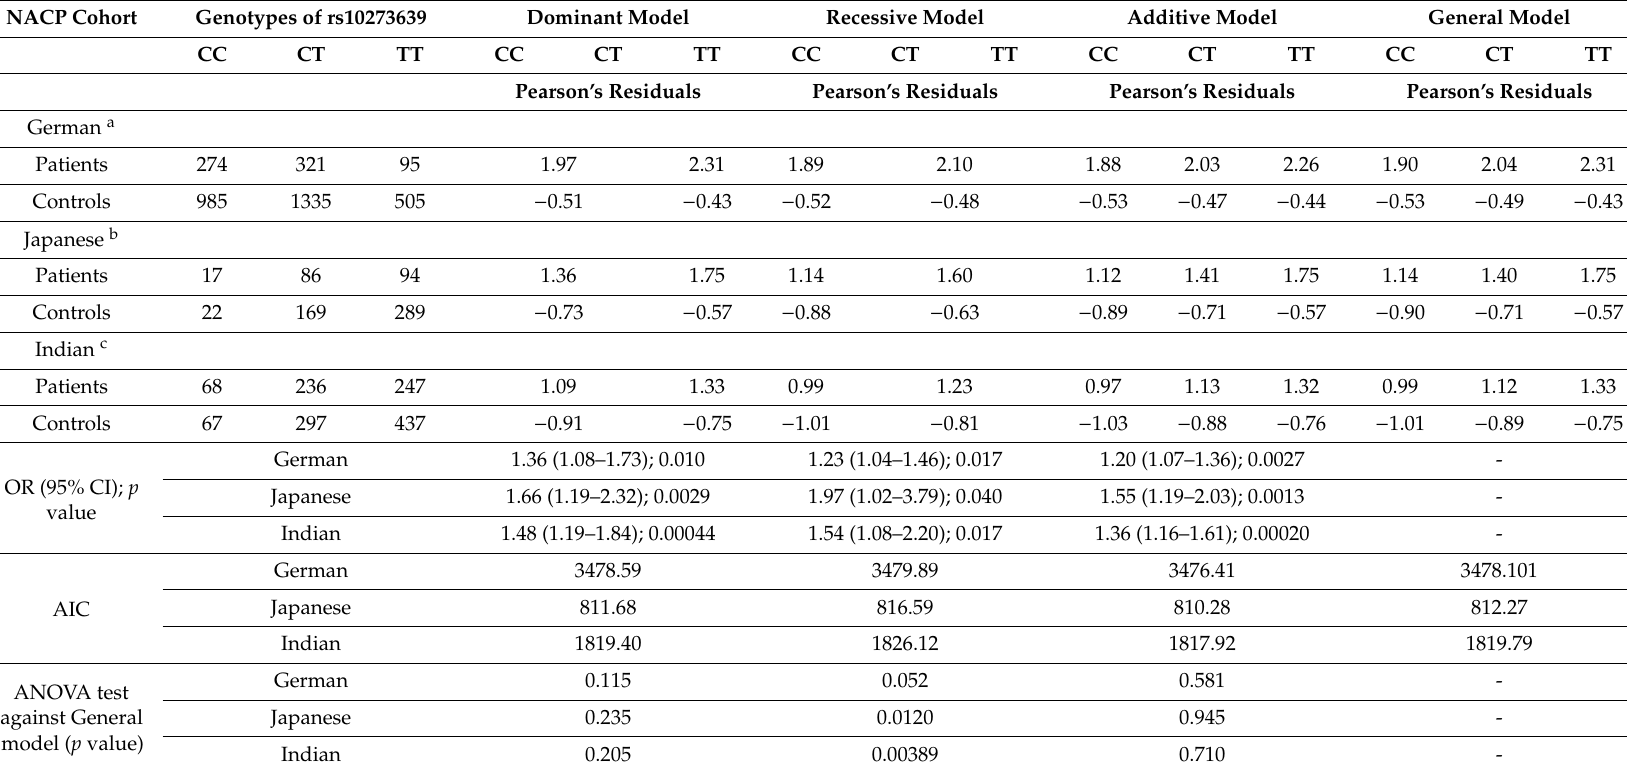
Table 3. Test of the fit of di ff erent genetic models to the gene association data in three NACP